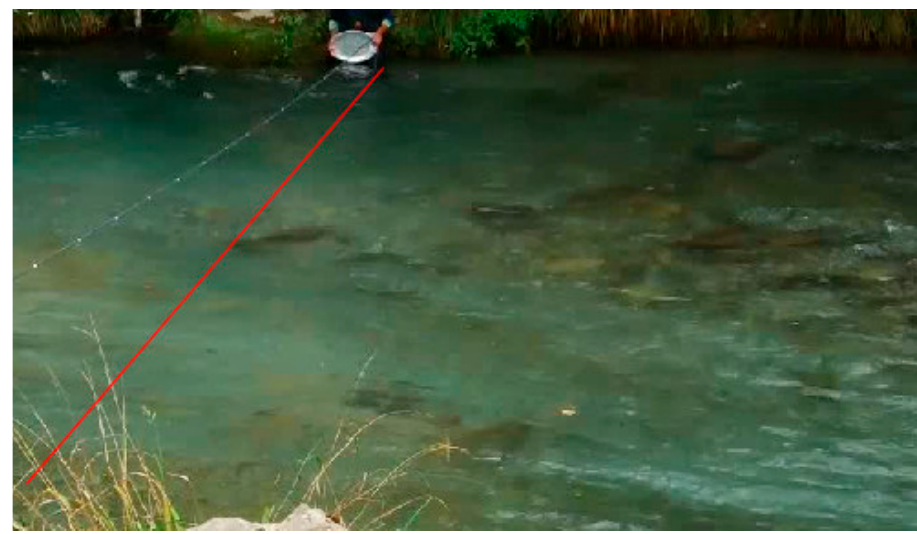
Figure 6. A part of the frame from the Loussios River at Atsicholos Bridge video; the surface velocities are estimated along the displayed red line.